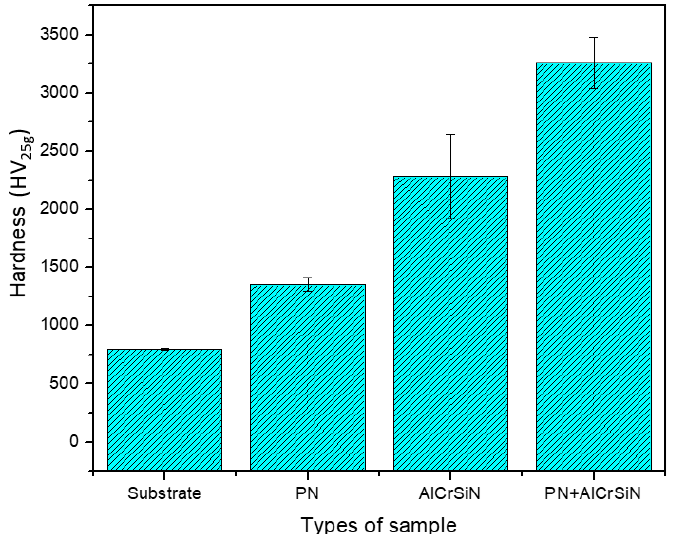
Figure 4. Vickers microhardnesses of the SKH9 high-speed steel substrate, PN-treated, AlCrSiN-coated, and PN + AlCrSiN-coated samples.